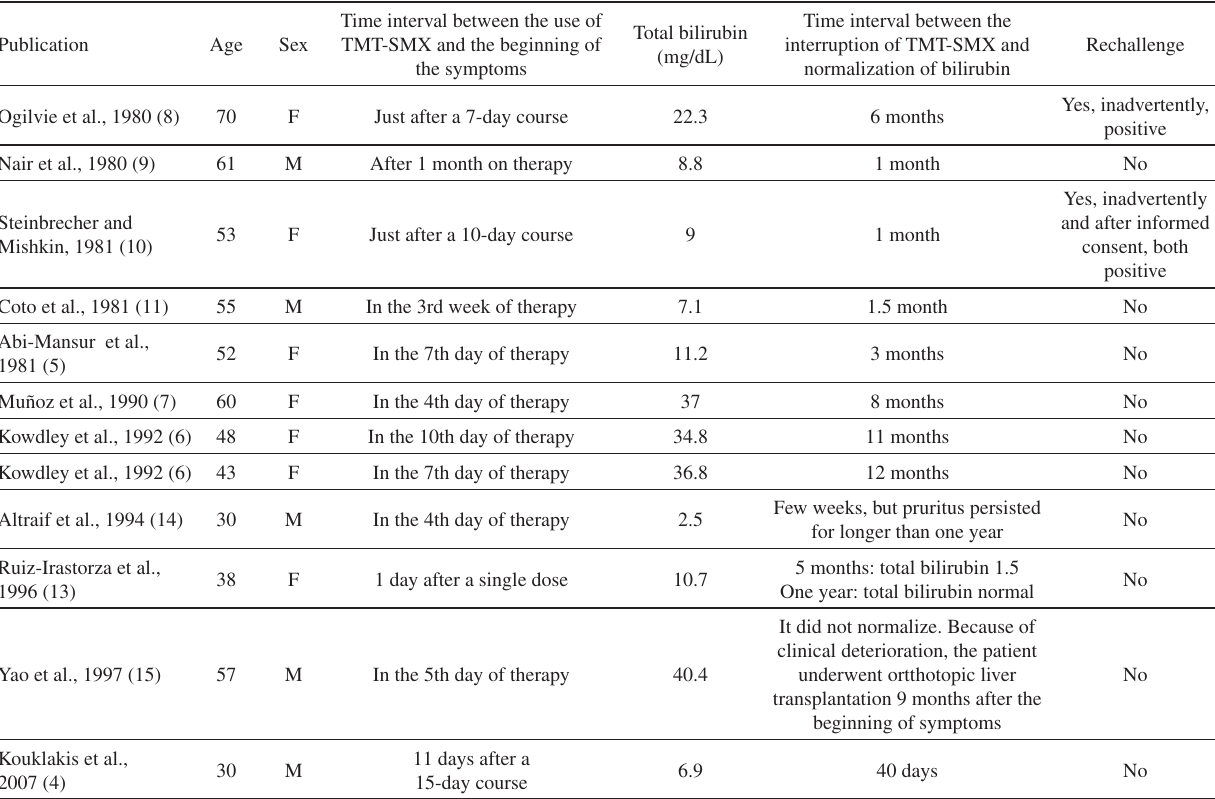
Table 1 - Cases of Trimethoprim-sulfamethoxazole (TMT-SMX) induced